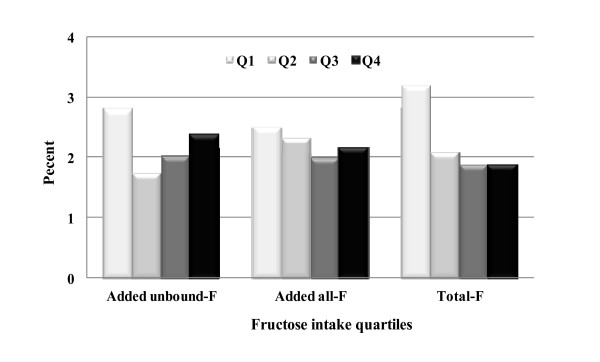
Hyperuricemia Rates by Fructose Intakes. F = fructose, compared to the intake quartile 1 (Q1), no statistical significance reached with the adjustment as indicated in statistical analysis.